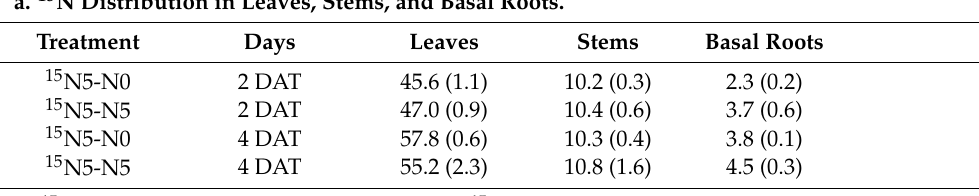
Table 1. Distribution of N derived from 15 N-labeled NO 3 − in each part of soybean plants with split root